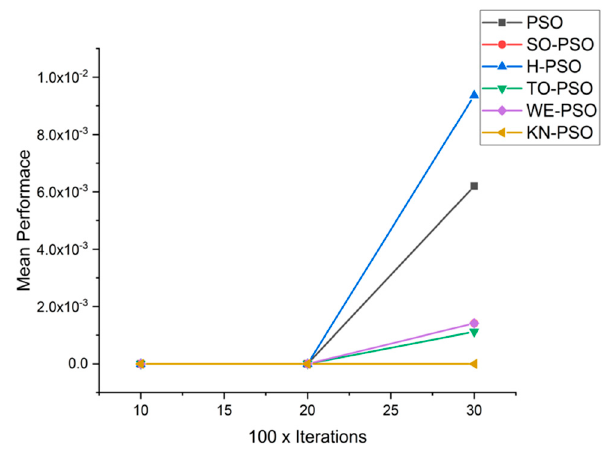
Figure 18. Convergence curve on fn12.